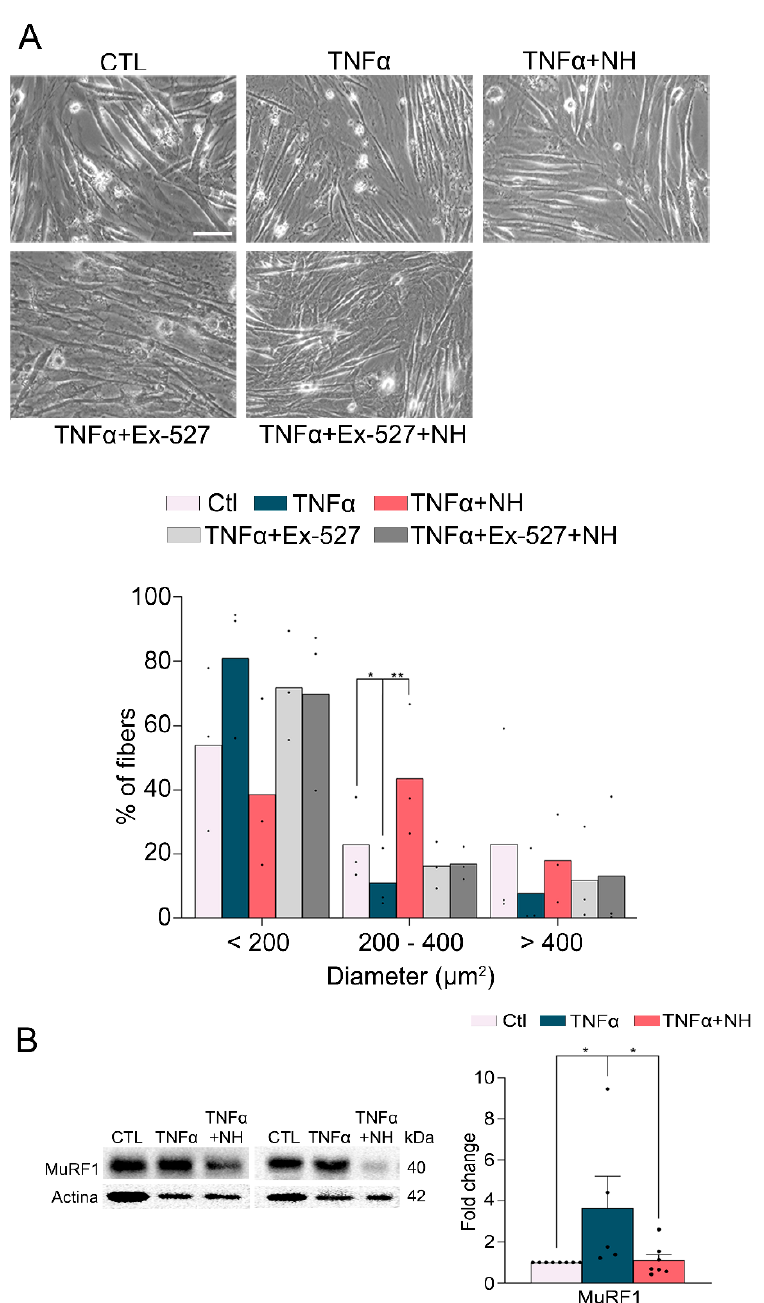
Figure 3. NeuroHeal reduces fiber atrophy produced by Tumor Necrosis Factor- α (TNF α ) in vitro. ( A ) Representative microphotographs of myotubes derived from a C2C12 myoblast cell line